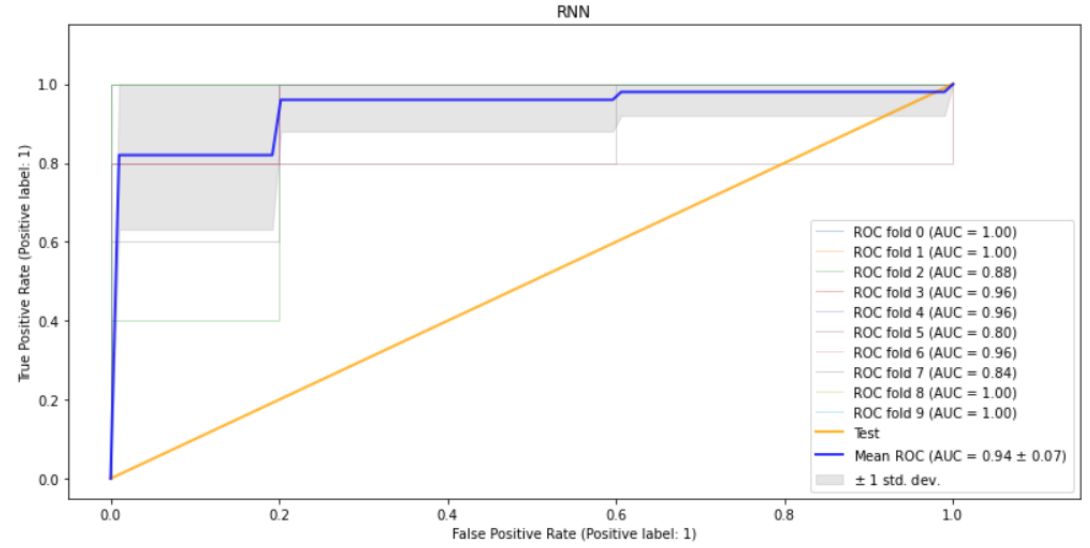
Figure 8. RNN’s training and testing loss.